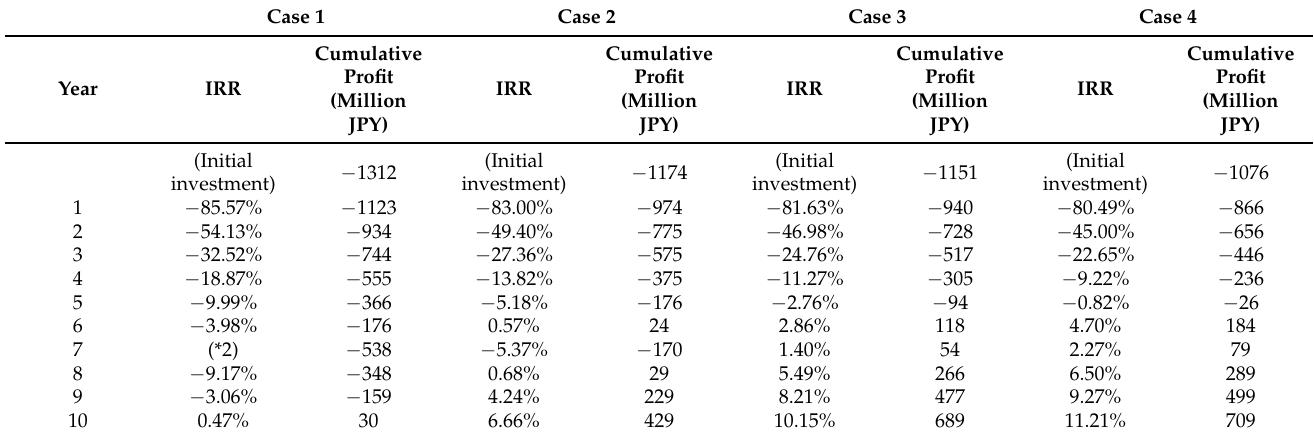
Table 6. IRR and cumulative profit (when predicted horizon is changed)